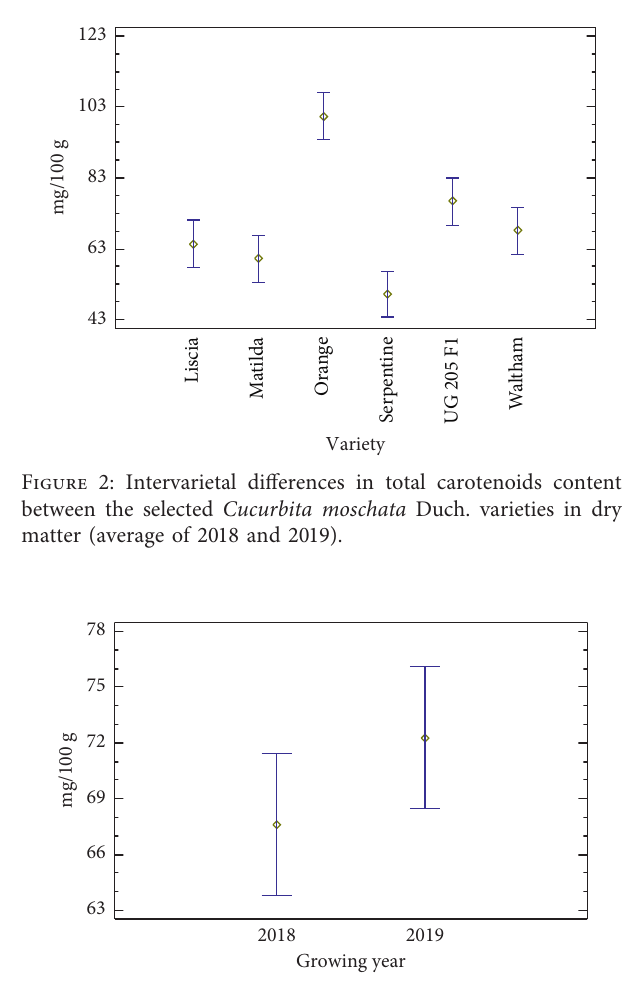
Figure 3: Interyear differences in total carotenoids content in all varieties and in the growing years 2018 and